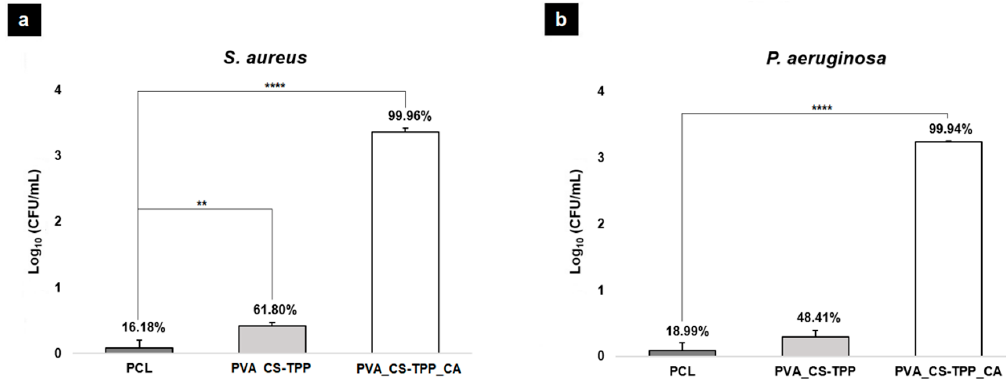
Figure 6. Evaluation of the antibacterial potential of the PCL’s top layer and the PVA_CS-TPP_CA and PVA_CS-TPP_CA’s bottom layers against Staphylococcus aureus ( S. aureus ) ( a ) and Pseudomonas aeruginosa ( P. aeruginosa ) ( b ). (Data are represented as average ± standard deviation (S.D.), ** p < 0.001 and **** p < 0.0001).